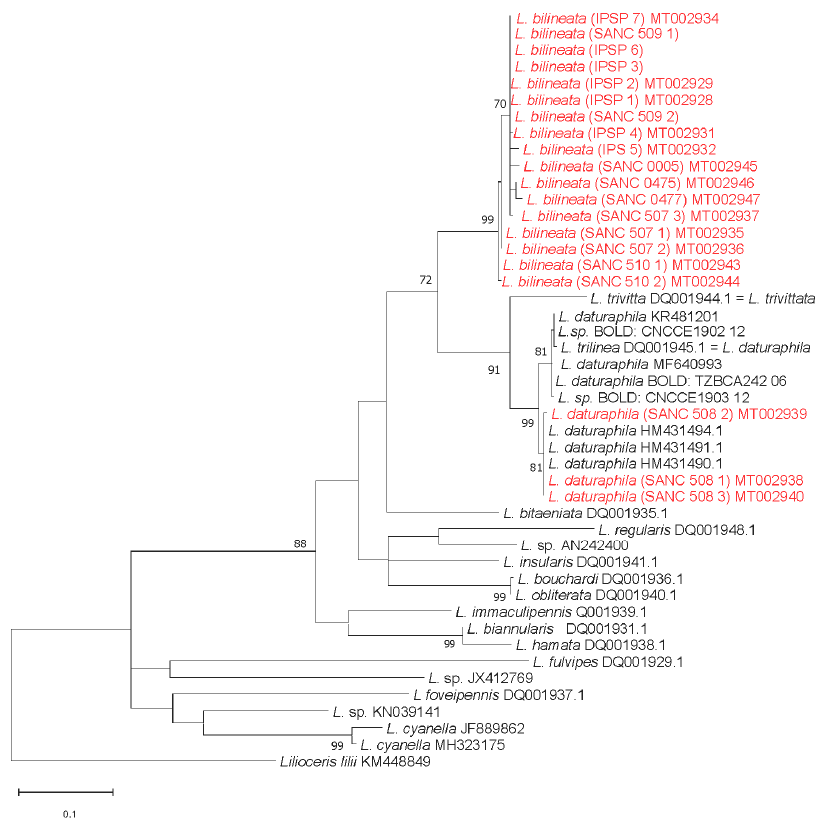
Figure 5. Phylogeny generated from maximum likelihood (ML) analysis of the cytochrome c oxidase I (COI) sequences from Lema species. The GenBank or Barcode of Life Data (BOLD) accession numbers of the sequences are reported. The nodes are marked by their ML bootstrap values, which are estimated from 10,000 bootstrap replicates. Only bootstrap values higher than 70% are shown. The novel sequences are in red.